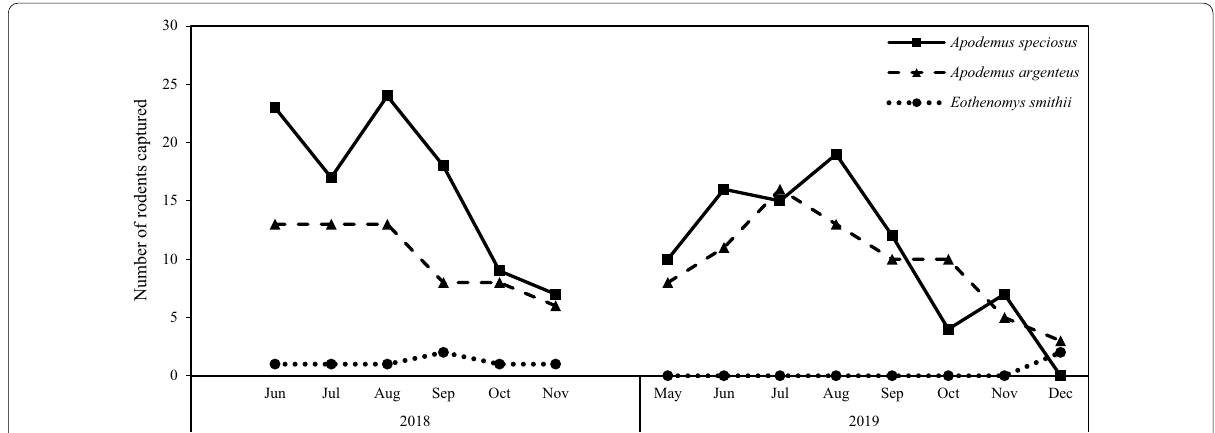
Fig. 2 Seasonal changes of the monthly number of rodents captured across the four plots from June to November 2018 and from May to December 2019. If the same rodent was captured on two consecutive nights, the number was assumed to be one